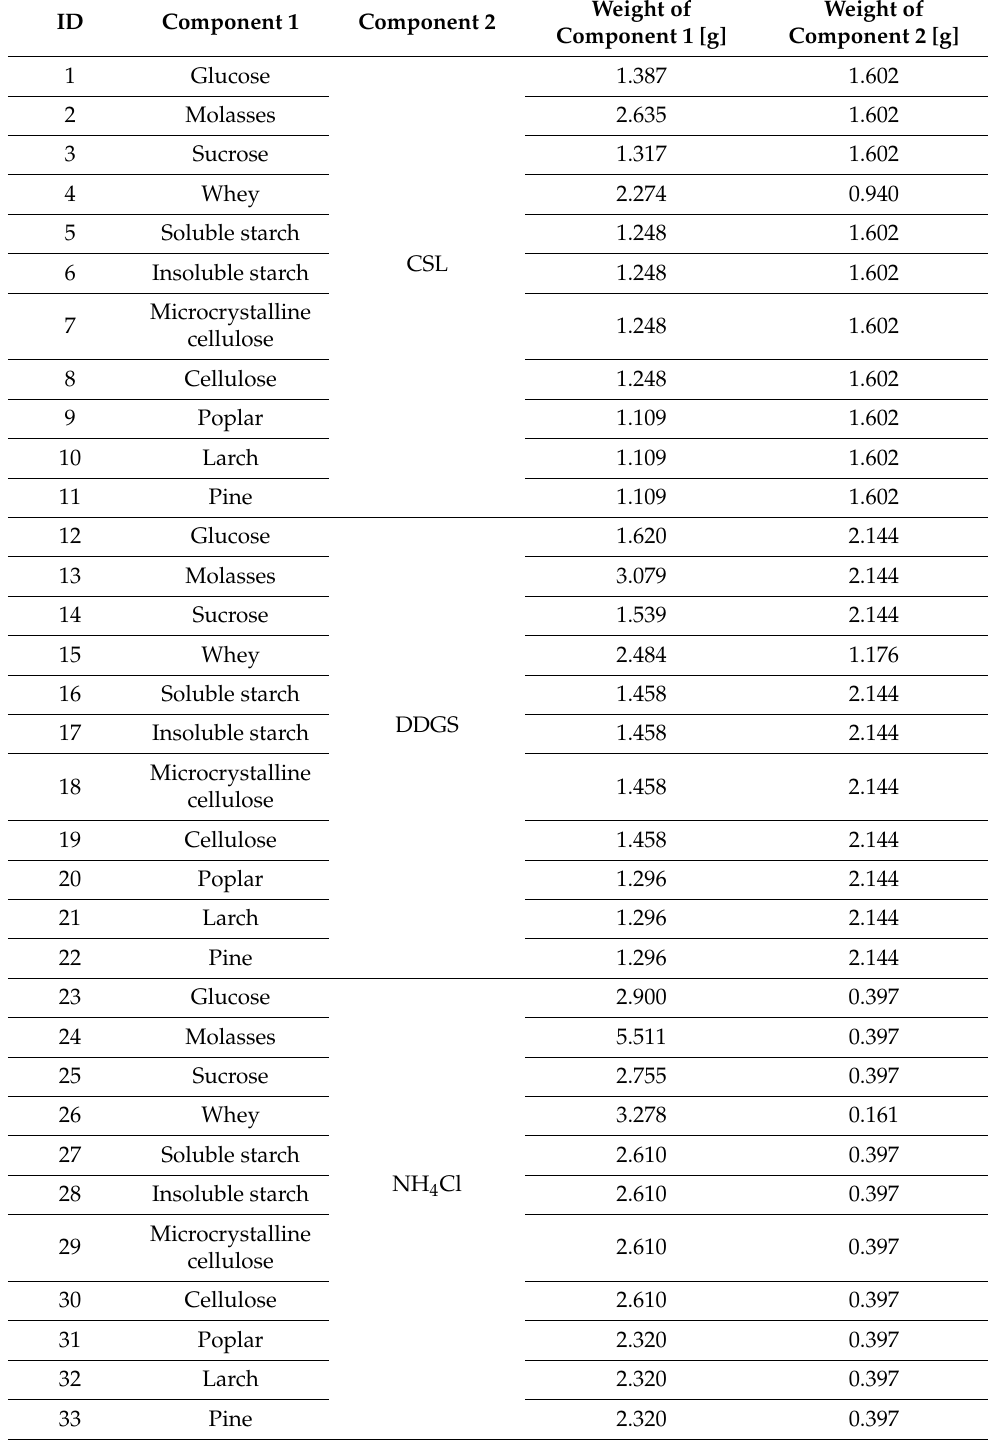
Table 1. Screening test: composition of tested culturing